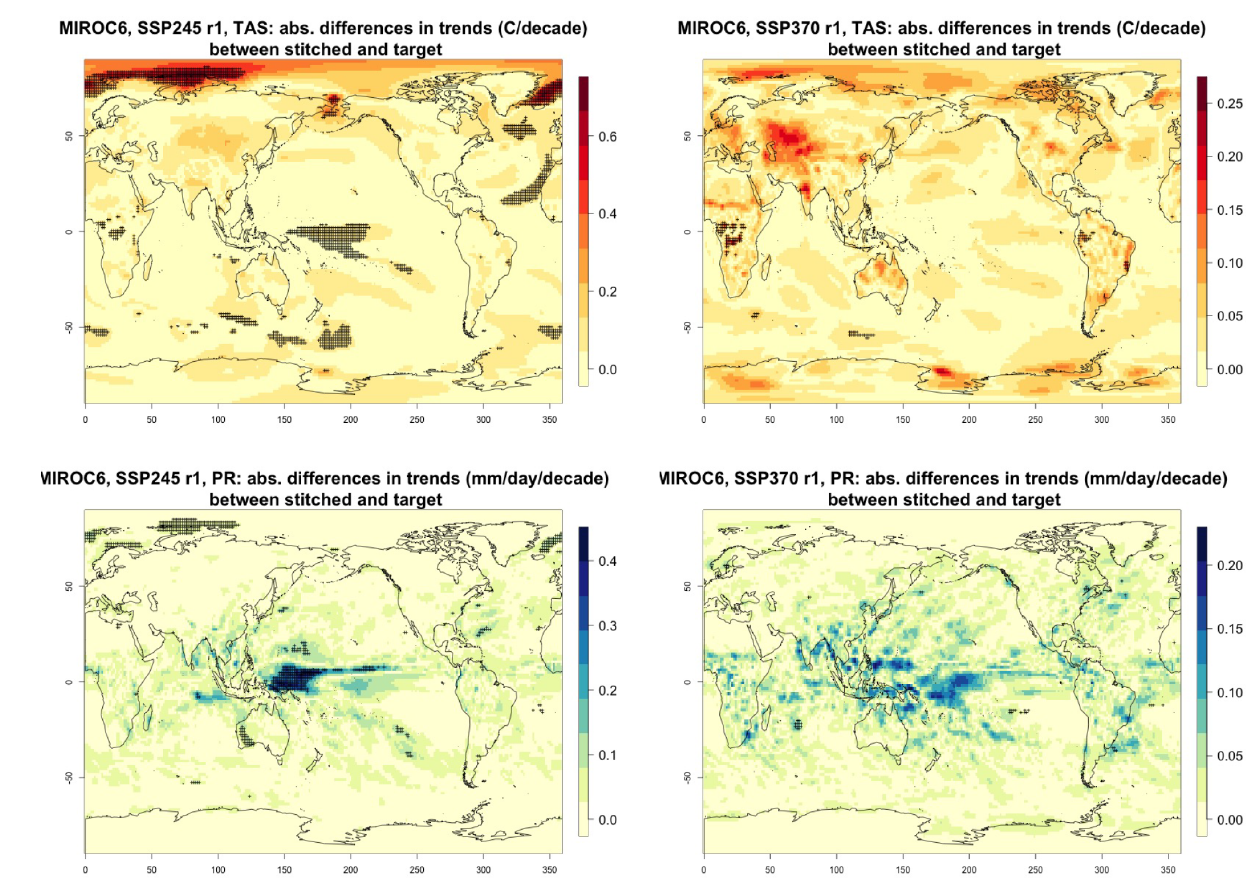
Figure C1. Absolute difference in decadal trends of temperature (TAS) and precipitation (PR) between stitched and target realizations. The value of the difference is expressed by the color scale, and we marked as significant with black crosses those locations where the 95% confidence intervals of the trends computed from target and stitched time series do not overlap, indicating statistically significant differences. Emulation of MIROC6, monthly time series over 2015–2100, for SSP2-4.5 and SSP3-7.0. First realization.